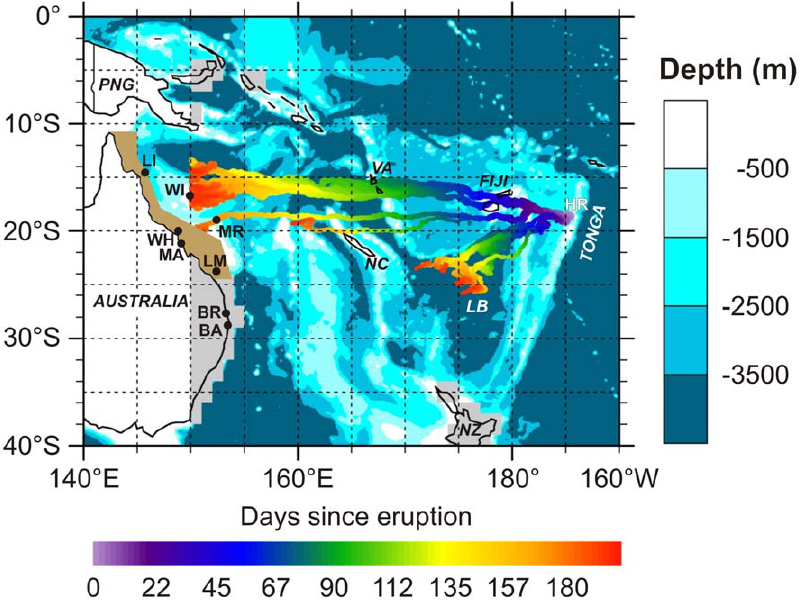
Figure 2. Trajectory map of the 2006–2007 pumice rafts, based on the integrated surface velocity field. Pumice strandings following the Home Reef (HR) eruption were reported at the following locations: Fiji ( , 33 days); Vanuatu (VA, 88 days); New Caledonia (NC, , 115 days); Willis Island (WI, , 180 days); Lizard Island (LI, , 200 days); Mackay (MA, , 250 days); Broadbeach (BR, , 250 days). Other abbreviations: LB, Lau Basin; NZ, New Zealand; PNG, Papua New Guinea; MR, Marion Reef; LM, Lady Musgrave Reef; WH, Whitsunday Island; BA, Ballina. Brown shaded region along northeastern Australia is the Great Barrier Reef World Heritage Area. Grey areas without bathymetric information represent continental shelves of , 1000 m depth, where geostrophic ocean currents were not calculated. An animated version of the pumice raft trajectory is provided in Supporting Information (Figure S1) to this paper.